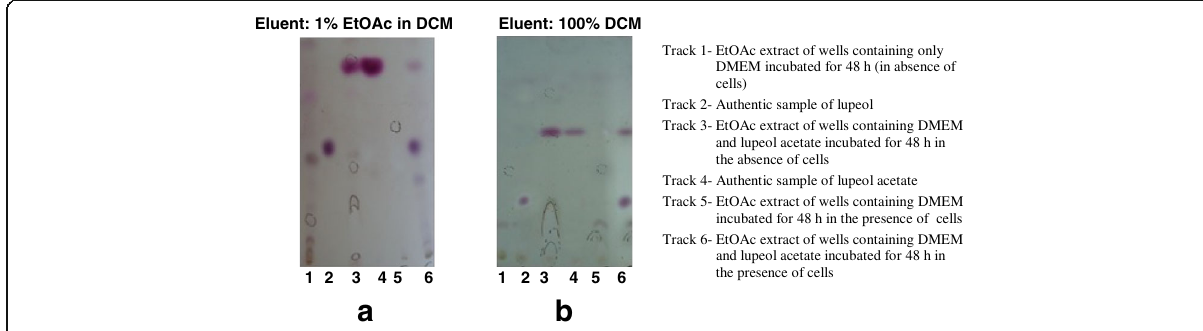
Fig. 8 Thin Layer Chromatographic comparison of the EtOAc extracts showing hydrolysis of lupeol acetate during scratch wound assay (SWA) ( a ) BHK Cells. ( b ) MDCK cells. Spray reagent: Anisaldehyde spray